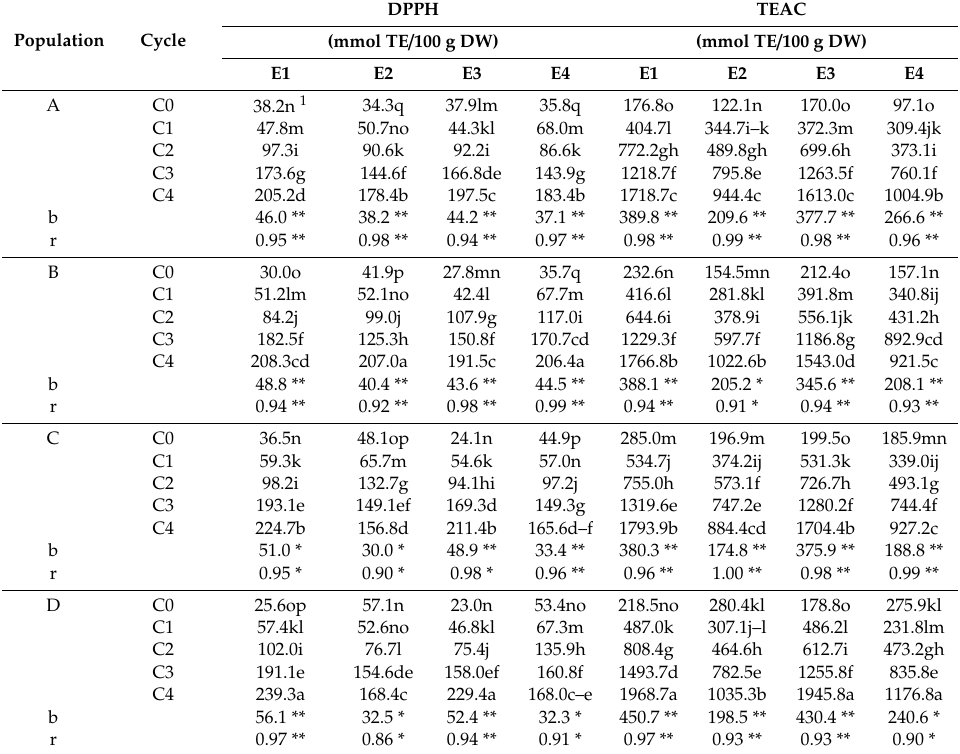
Table A8. Means for antioxidant activity determined by the DPPH and the TEAC methods of (A–E) five populations and (C0–C4) five cycles in cob evaluated in four